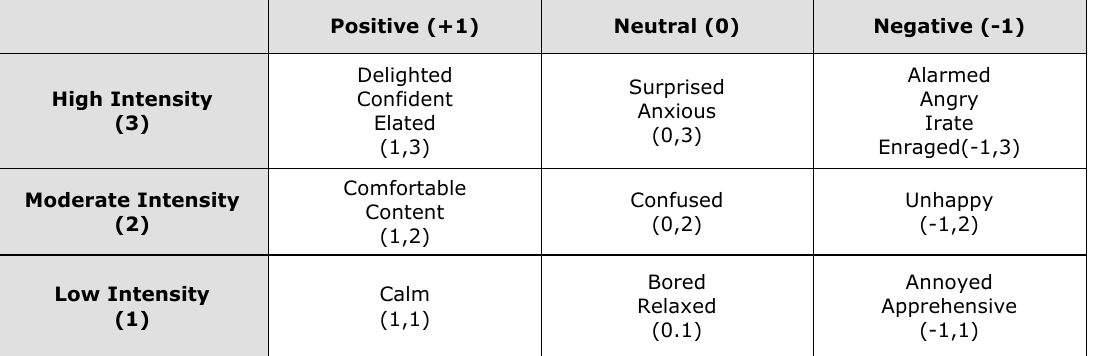
Table 2. “Distribution of emotions by their valence and